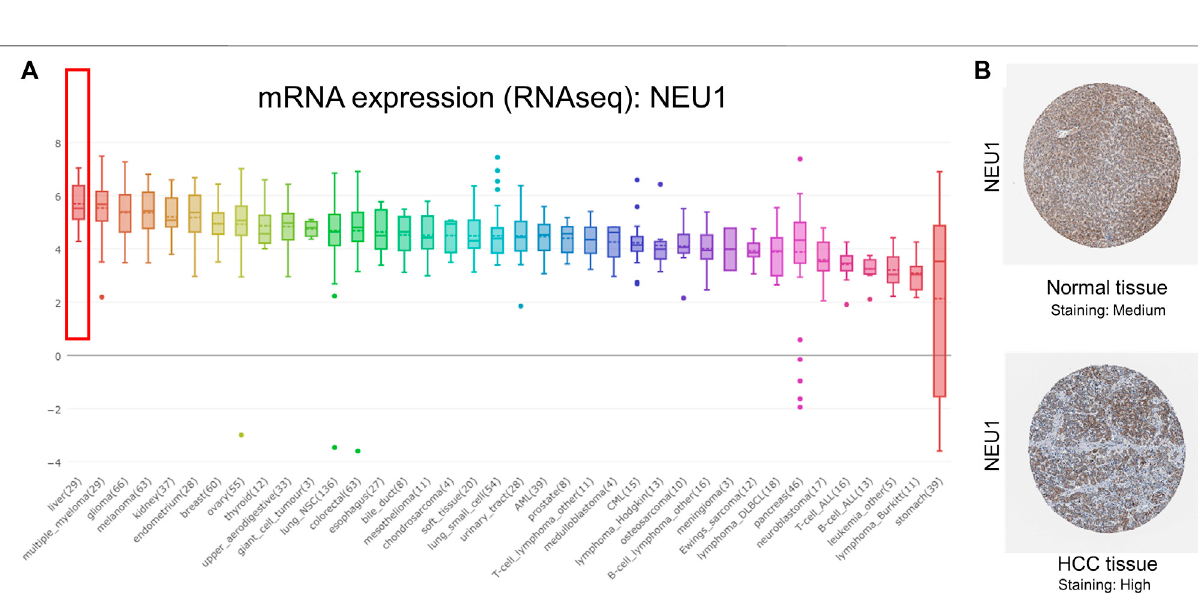
analysis indicated the existence of a positive correlation between